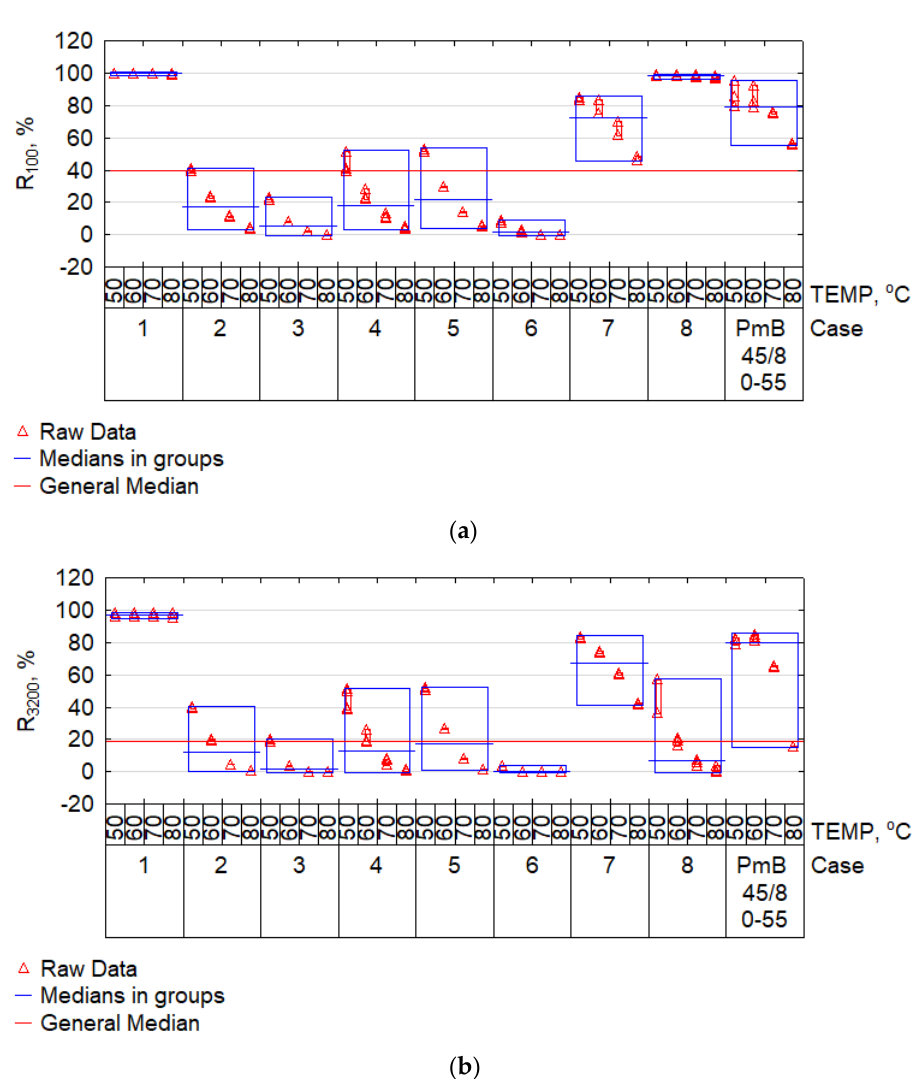
Figure 8. Plot of creep compliance Jnr for shear stress: ( a ) 100 Pa (Jnr 100 ); ( b ) 3200 Pa (Jnr 3200 ).